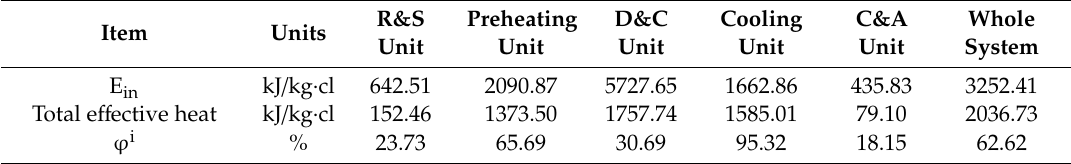
Table 6. Thermal e ffi ciency of one 5000 MT / D production line after